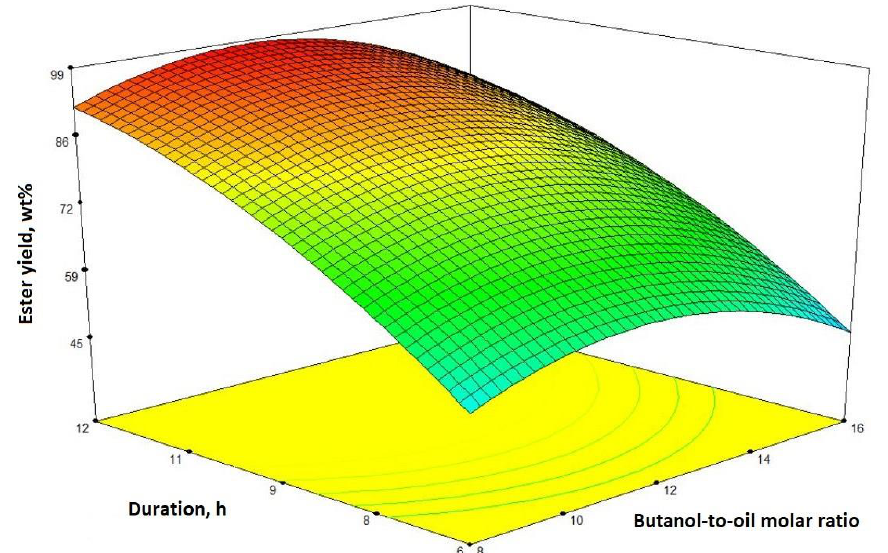
Figure 2. The interaction between the process time and the 1-butanol-to-oil molar ratio for the ester yield (catalyst content is 8 wt%) presented by a response surface contour plot.